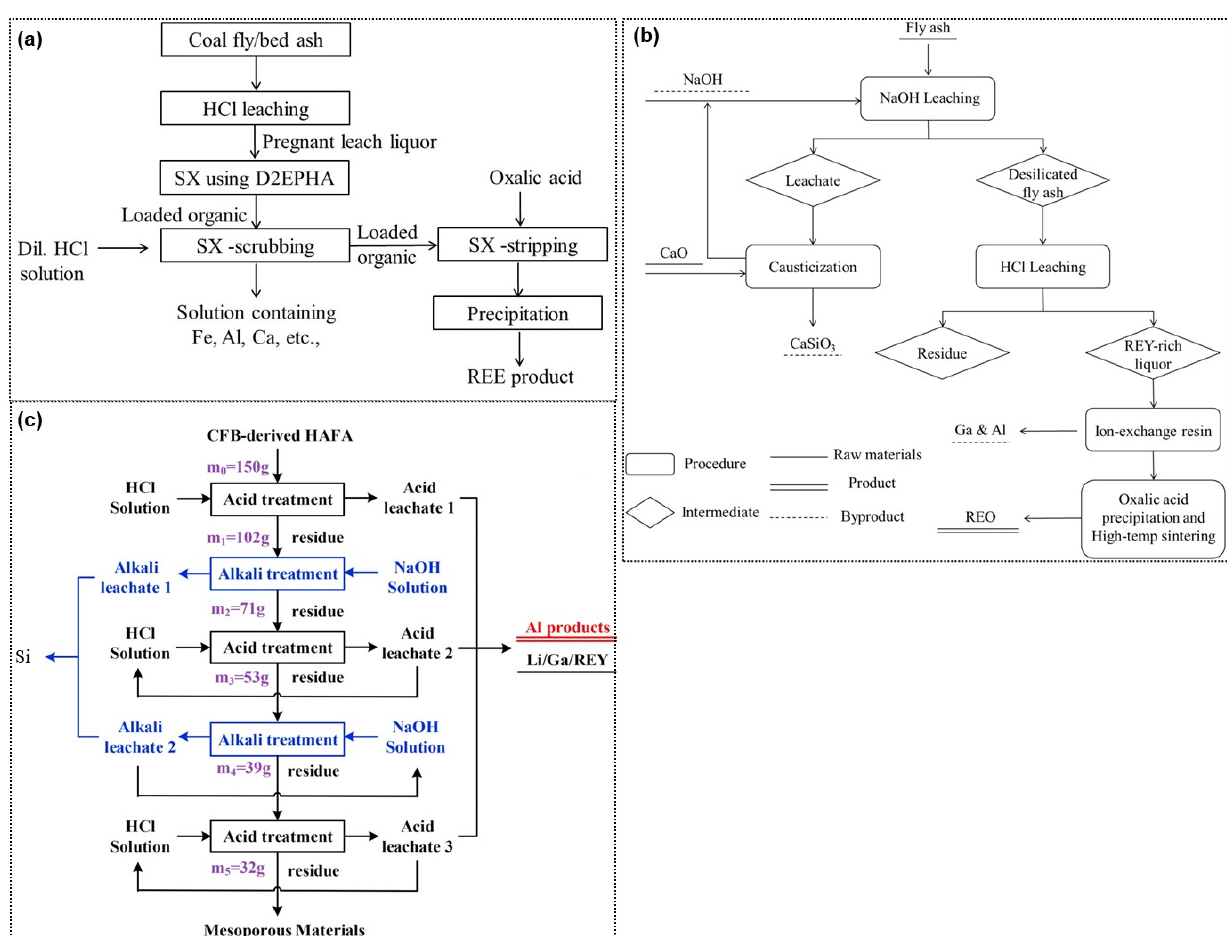
Figure 12. General flow sheets of different treatment routes to recover rare earths from the coal fly ash, consisting the HCl leaching-solvent extraction technique ( a ), two-step alkali and acid leaching ( b ), and multi-stage alkali and acid leaching process ( c ) [206,209,211].